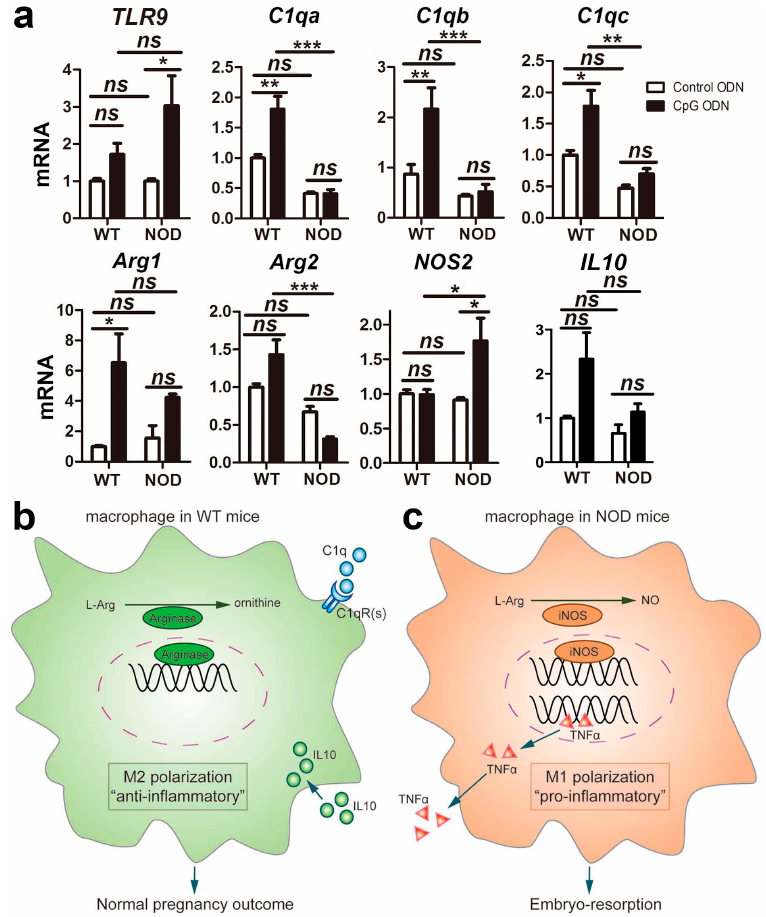
Figure 5. Complement C1q and M1/M2 macrophage polarization: ( a ) the expression levels of TLR9 , three components of C1q ( C1qa , C1qb and C1qc ), M1/M2 markers (arginase and inducible nitric oxide synthase), and IL10 in WT and NOD mice with CpG Oligodeoxynucleotide (CpG ODN) or control ODN treatment; ( b ) M1/M2 macrophage polarization in WT mice with CpG ODN treatment; and ( c ) M1/M2 macrophage polarization in NOD mice with CpG ODN treatment. qRT-PCR was performed